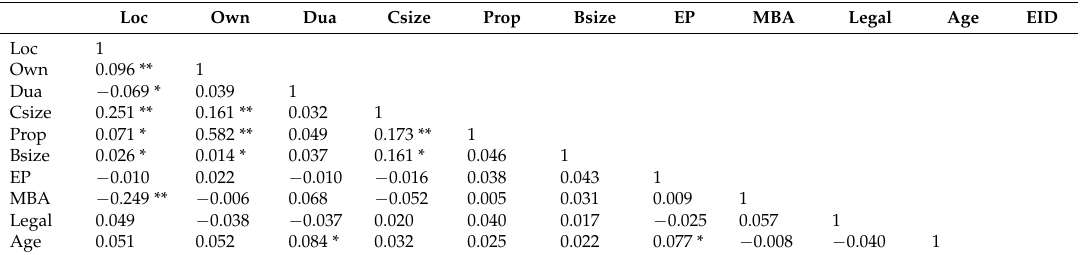
Table 1. The descriptive statistics and their correlation